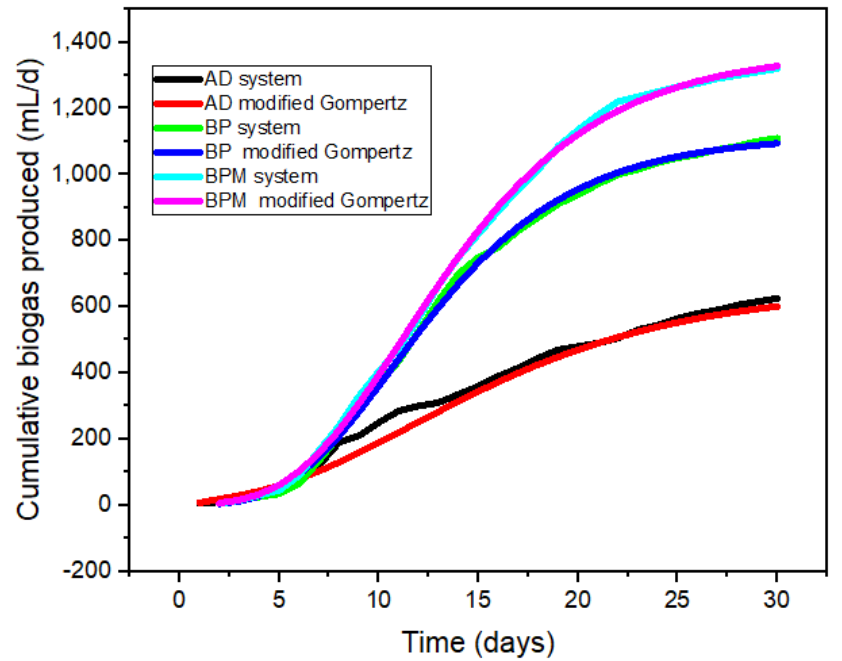
Figure 4. Bioreactor cumulative biogas production fitted with modified Gompertz kinetic model for the 30-day incubation. Table 3. Summary of modified Gompertz kinetic model parameters.